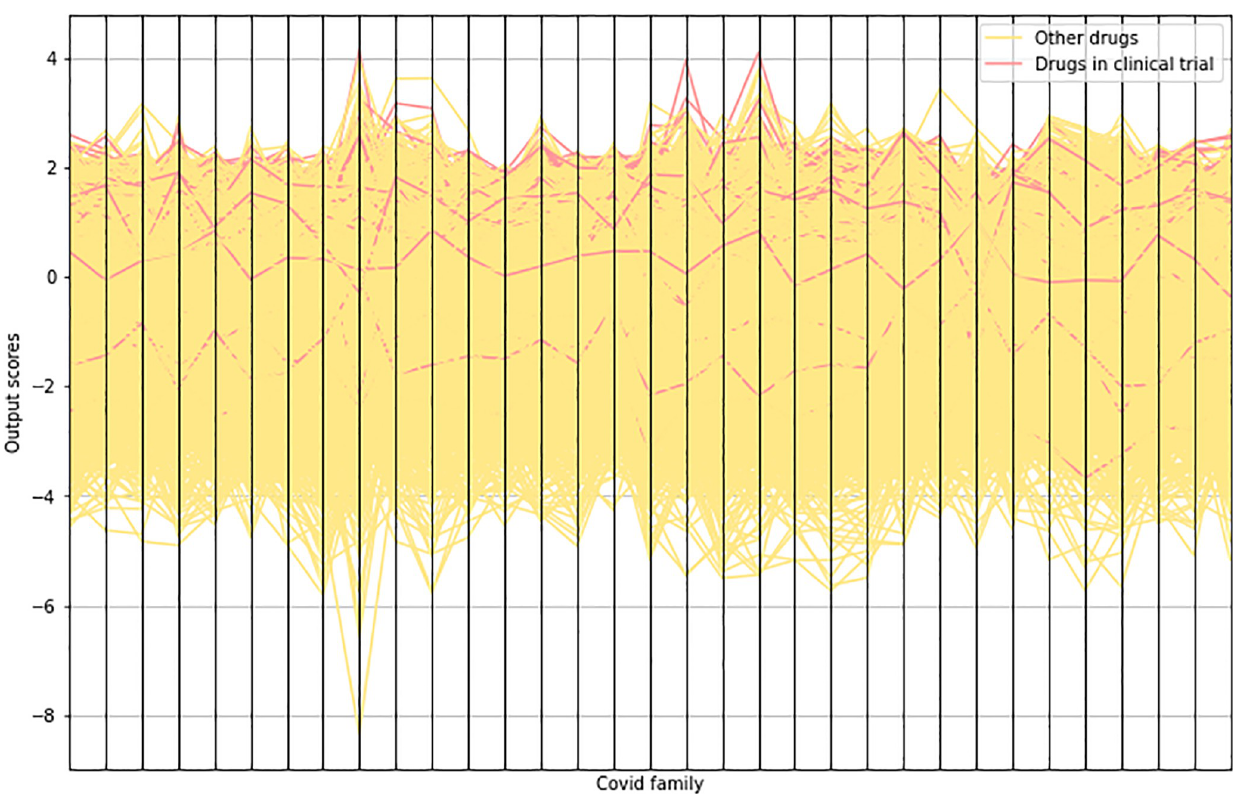
Fig 3. Link prediction scores. Parallel coordinates plot showing the standardized scores output by our link prediction model. We highlight the drugs that are present in clinical trial. The plot shows a high correlation between the scores and being in clinical trial.